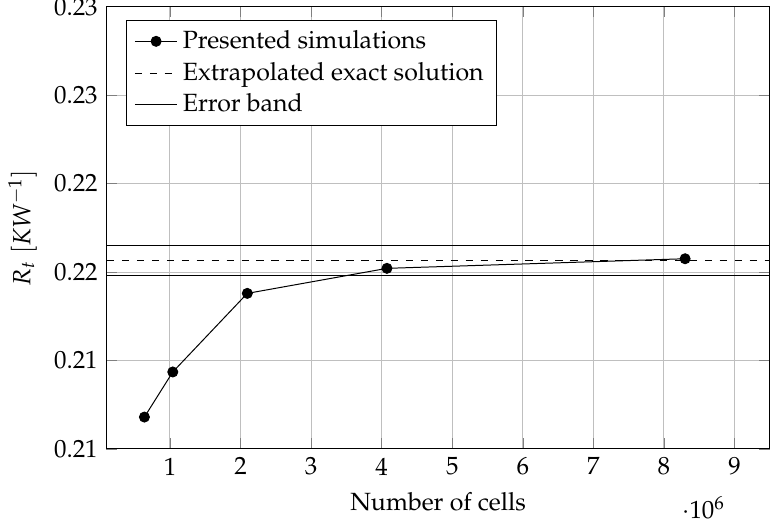
Figure 6. Sensitivity of changes with number of cells on thermal resistance ( R t